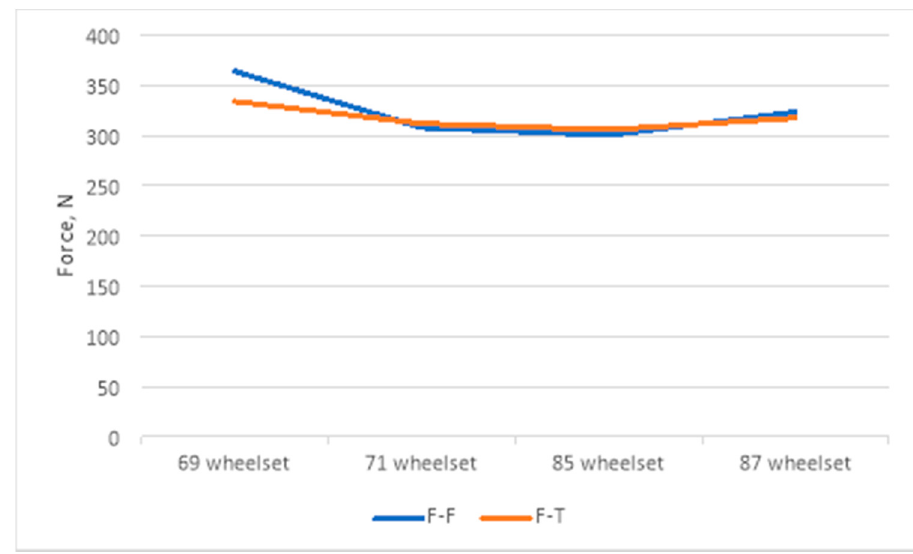
Figure 17. Comparison of physical and numerical experiment results. F-F—force results obtained from the physical experiment, F-T—force results obtained from the numerical experiment.